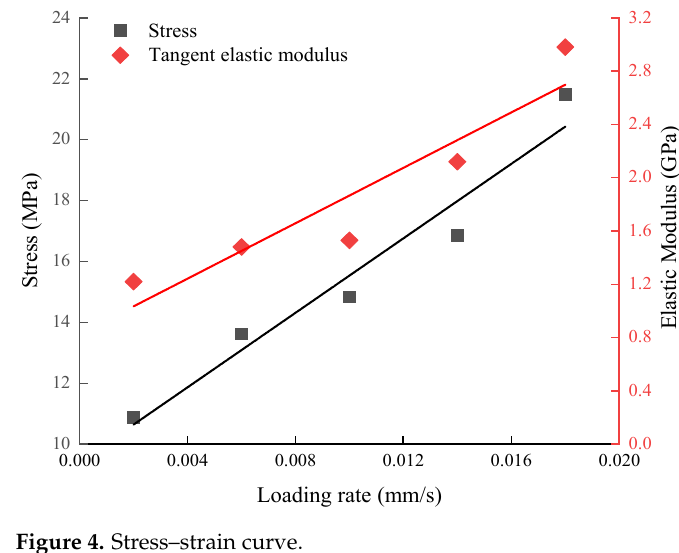
Figure 4. Stress–strain curve.